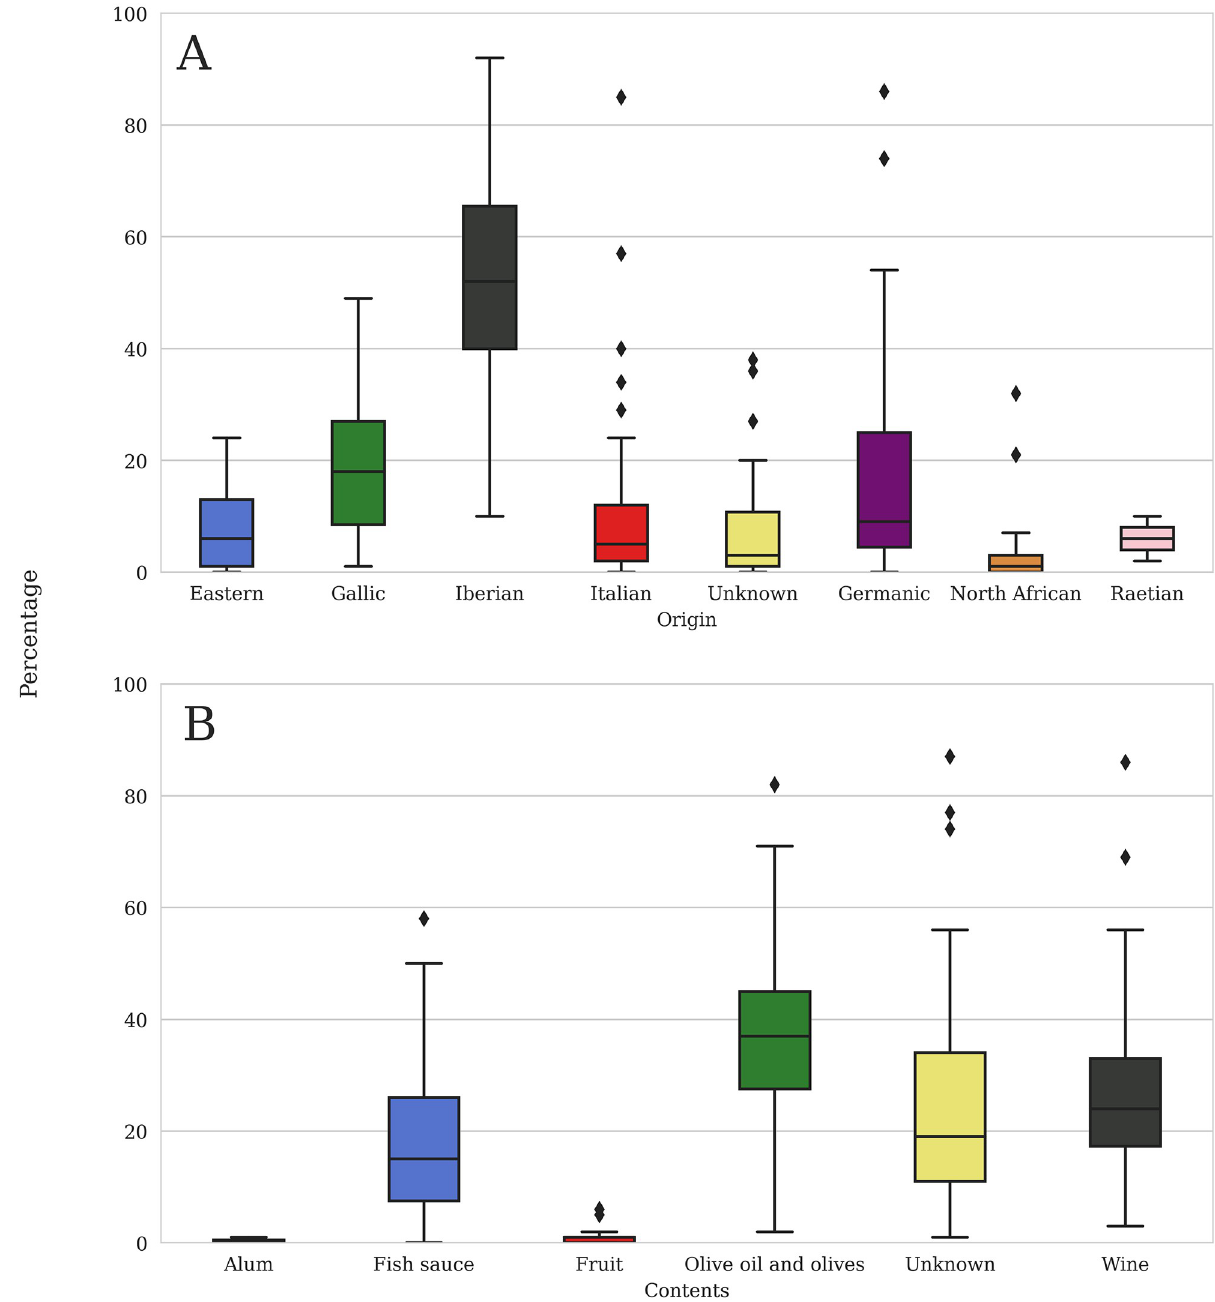
Fig 2. a-b. Amphora origins and contents. Box and whisker plots showing percentage of each origin and content as part of each site assemblage.